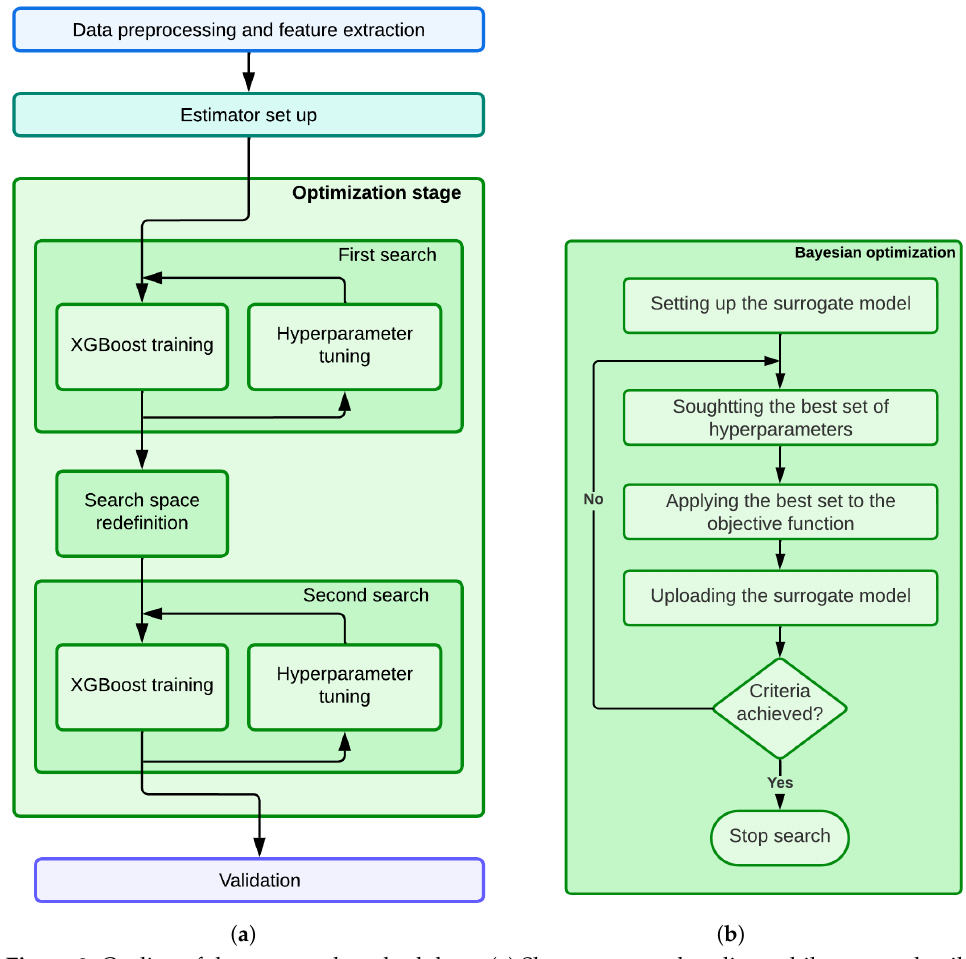
Figure 2. Outline of the proposed methodology. ( a ) Shows a general outline, while a more detailed explanation of the hyperparameter search using Bayesian optimization is shown in ( b